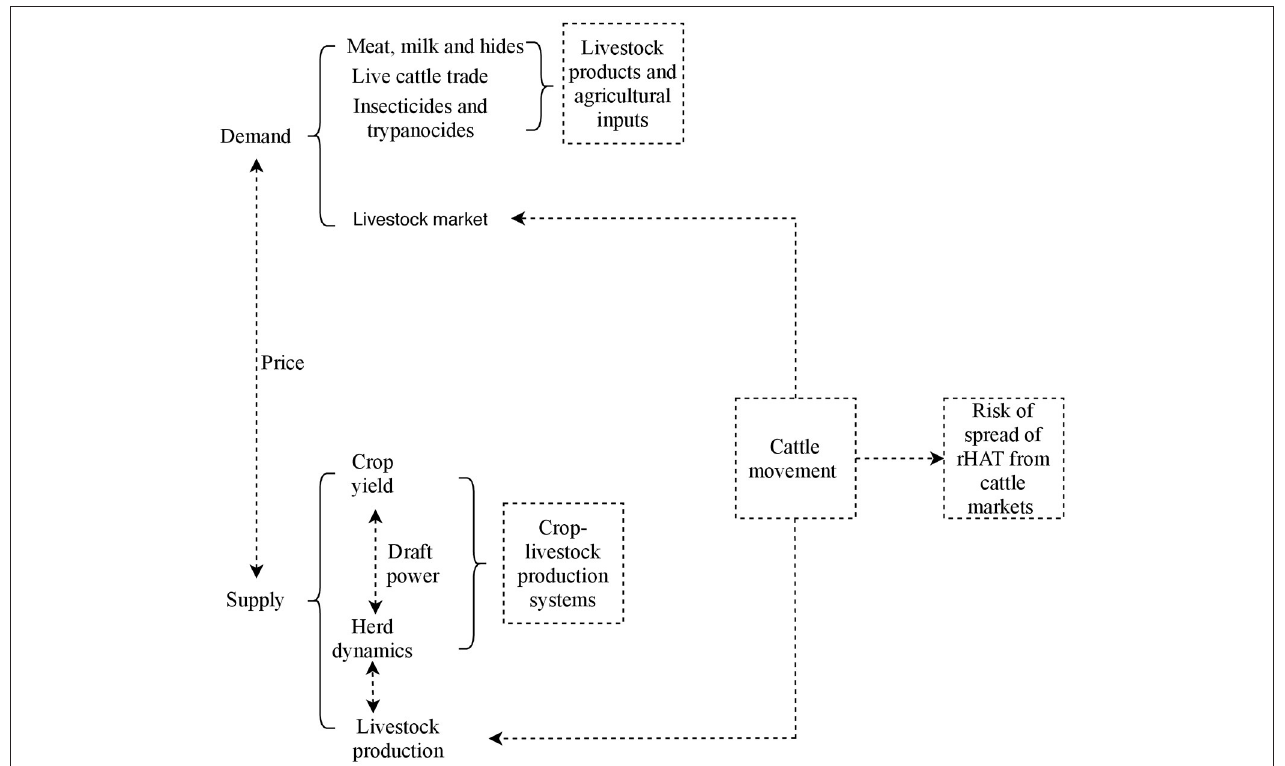
FIGURE 3 | Linkages between livestock production, market and spread of rHAT.